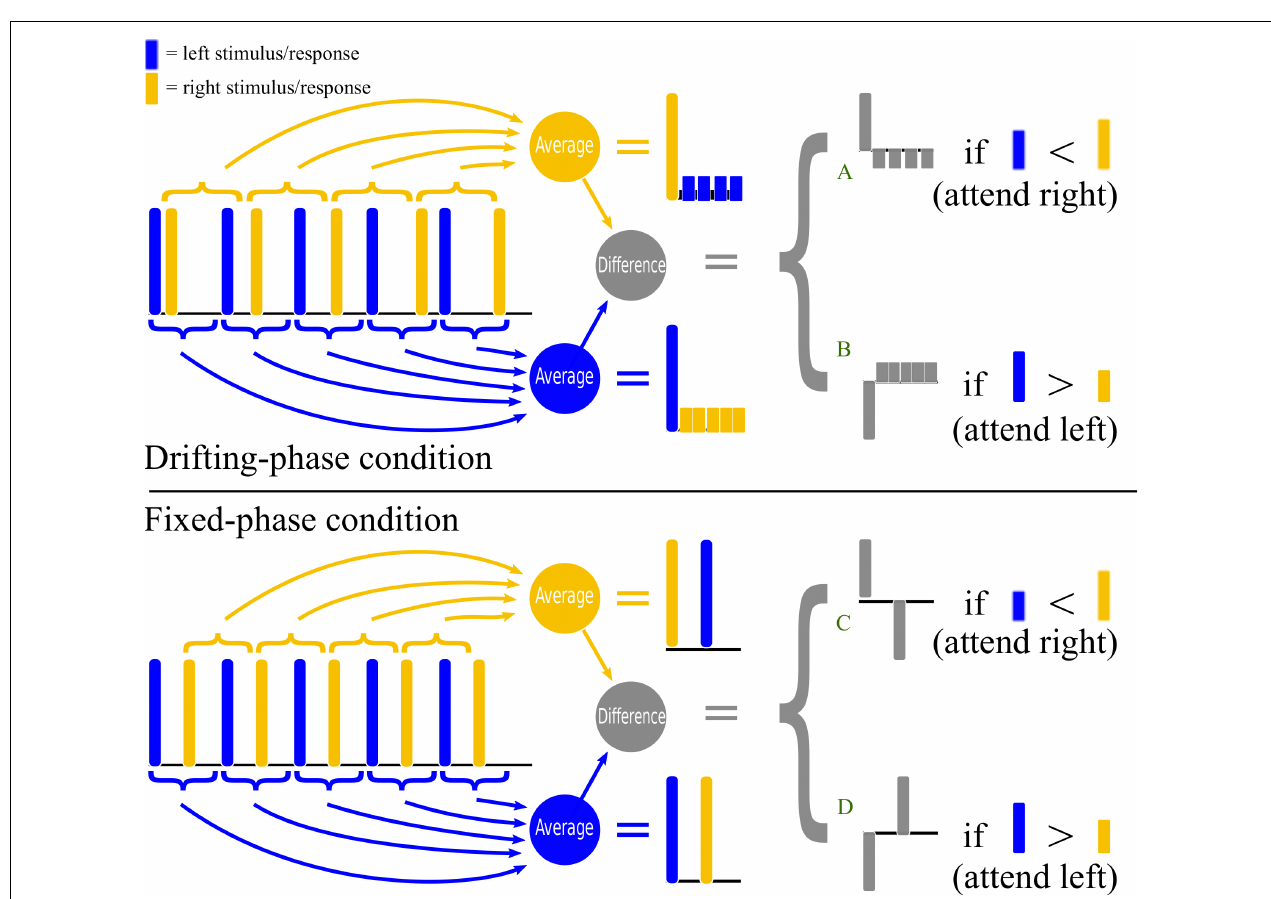
represented by dark blue pulses, whereas stimuli in the right stream (or the brain responses to them) are represented by light yellow pulses. Preprocessing consists of computing an average epoch time-locked to the left-stimuli onsets, and subtracting it from the average epoch time-locked to the right-stimuli onsets (see text for further